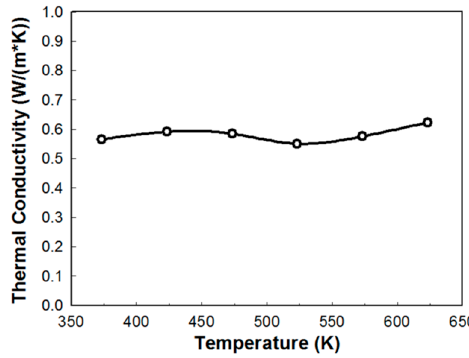
Figure 5. Temperature dependence of the thermal conductivity of Yb 8.41(4) Ca 5.58 AlSb 11 .